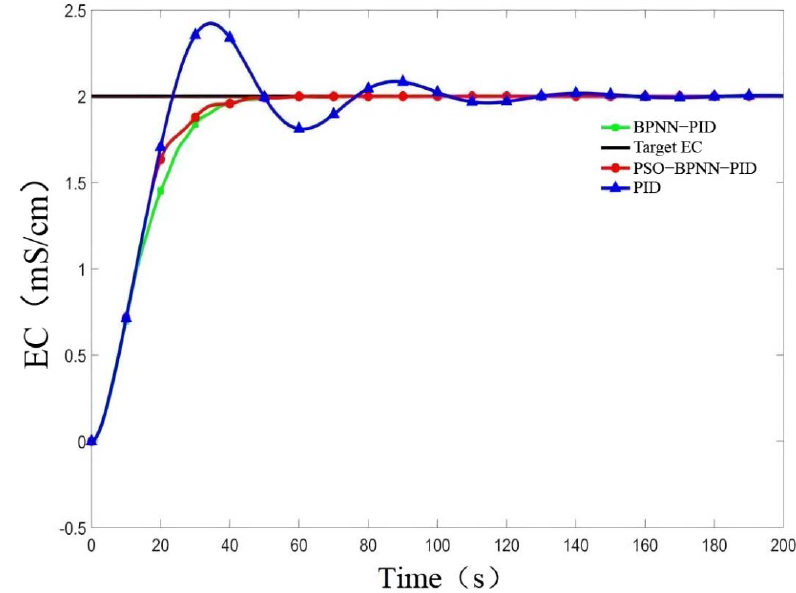
Figure 8. Comparison of different control results.